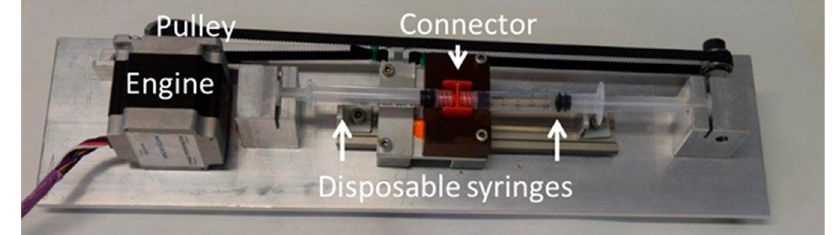
Figure 1. In house double syringe method used for foam designed at the University of Granada and manufactured by Producciones Científicas y Técnicas S.L. (Gójar, Spain).